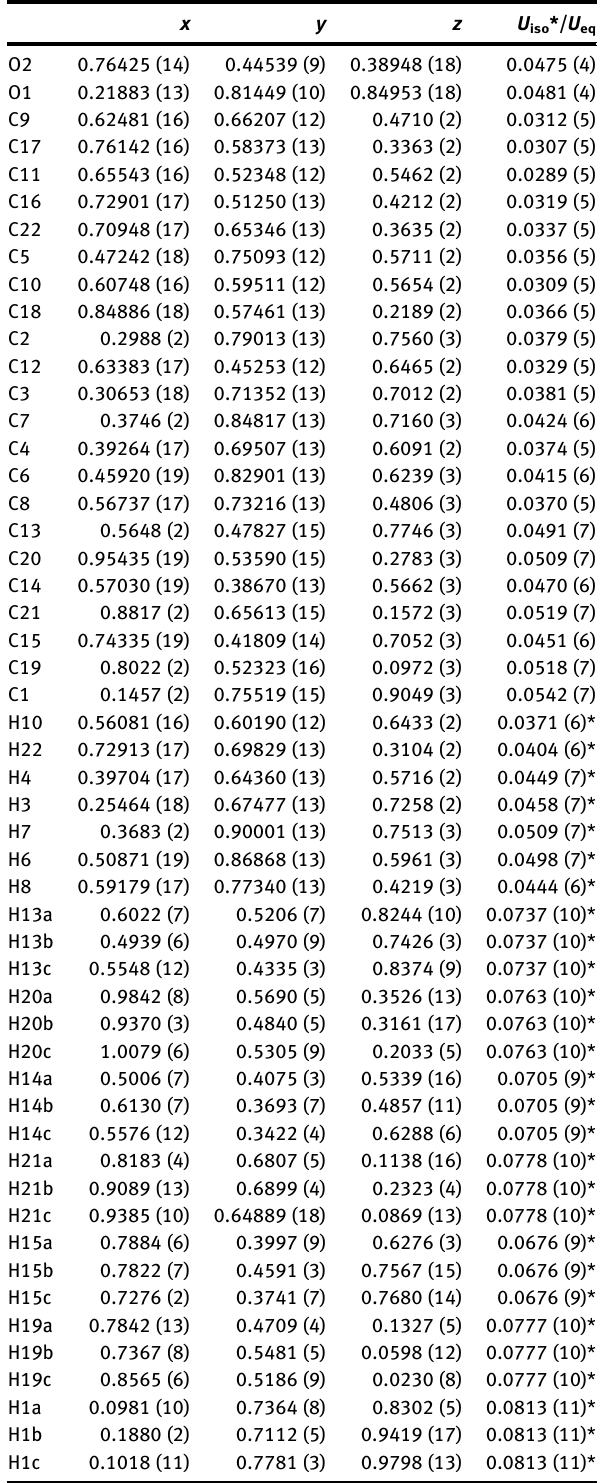
Table  : Fractional atomic coordinates and isotropic or equivalent isotropic displacement parameters (Å 